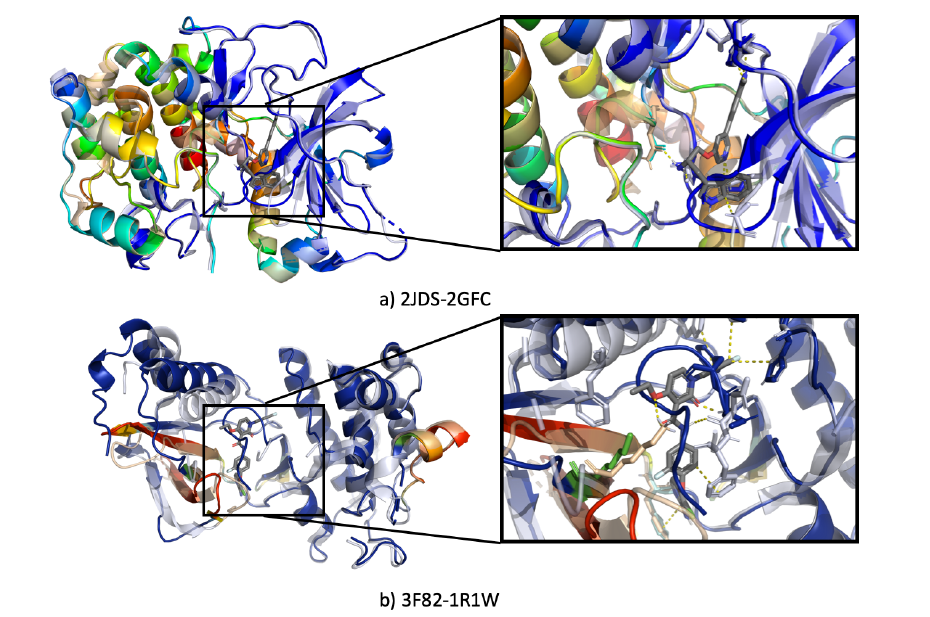
Figure 9. Heatmap generated from unbound protein for cryptic sites. The heatmap is a rainbow mapping with violet as the lowest and red as the highest value. The grey color shows bound protein with